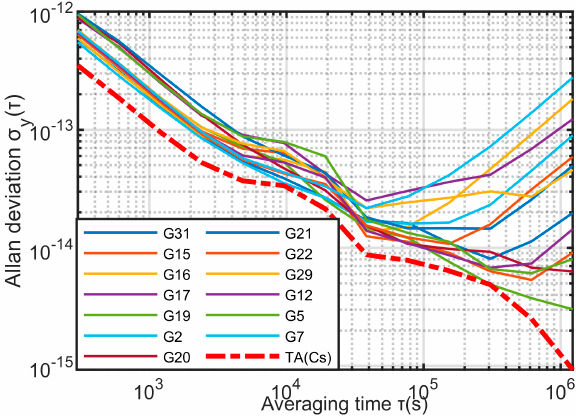
Figure 5. Frequency stability of cesium clock group.